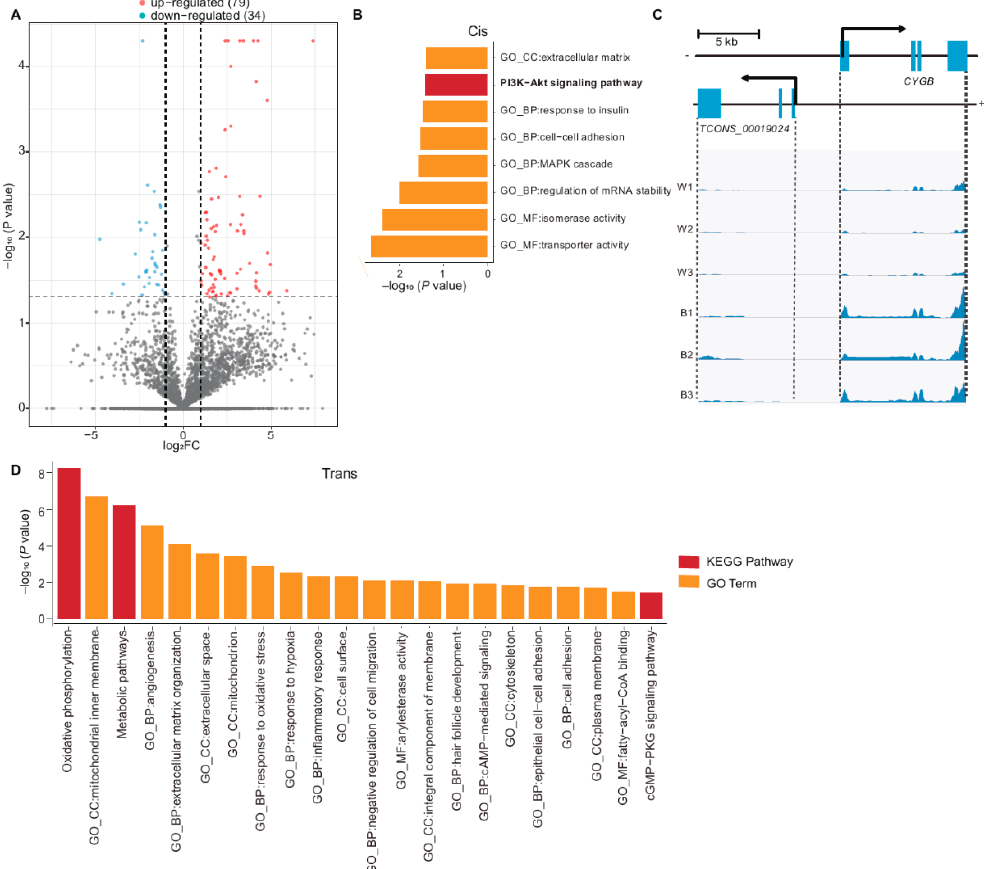
Figure 4. Functional enrichment analysis of DE lncRNAs. ( A ) DE lncRNAs between two groups (79 DE lncRNAs were up-regulated in white skin while 34 DE lncRNAs were down-regulated). ( B ) Functional enrichment analysis with 88 DE genes adjacent to DE lncRNAs ( p -value < 0.05). ( C ) Genomic location and reads abundance of TCONS_00019024 and its target gene CYGB . (Pearson correlation coefficient: 0.932, p = 0.01). ( D ) Functional enrichment analysis of trans target genes related to DE lncRNA.